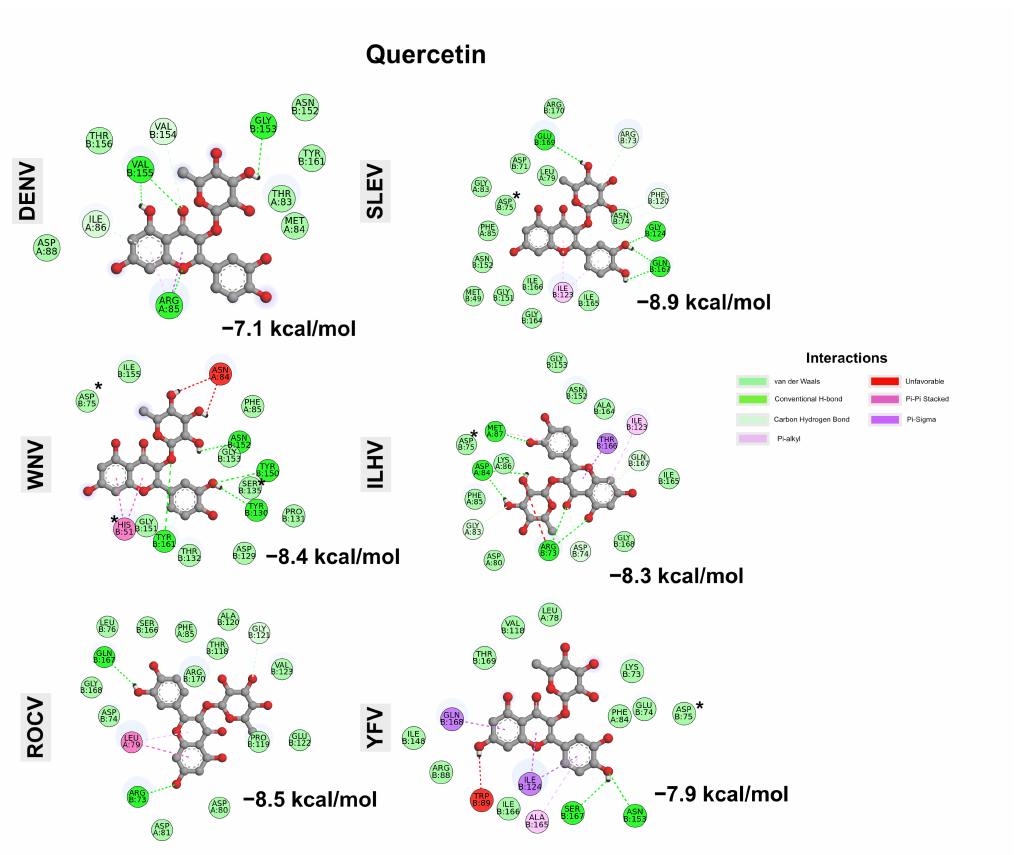
Figure 11. Interaction analysis of the best binding mode of quercetin in the NS2B–NS3pro proteins of dengue virus (DENV), West Nile virus (WNV), Rocio virus (ROCV), Saint Louis encephalitis virus (SLEV), Ilhéus virus (ILHV), and yellow fever virus (YFV). The residues from the catalytic triad are marked with *. ILHV NS2B–NS3pro is represented by Cluster 1 only. Cluster 2 is shown in Figure